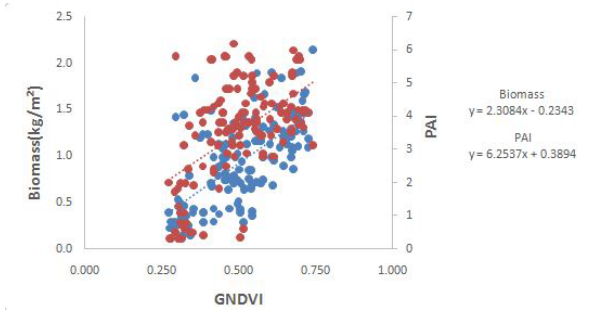
Figure 10. Statistical analysis of GNDVI with PAI and biomass.